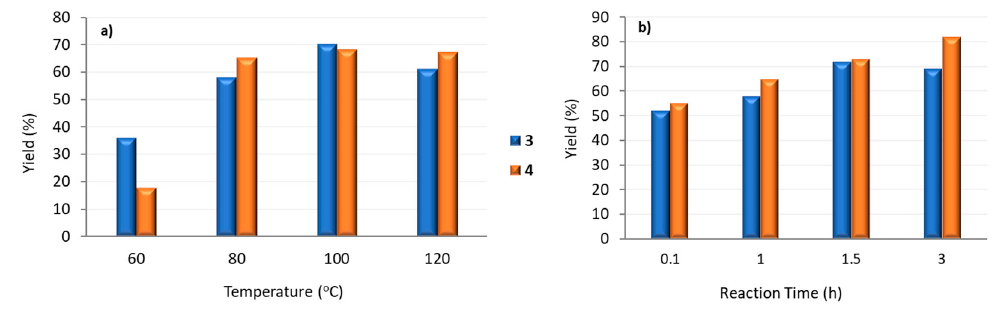
Figure 5. Effect of temperature ( a ) and reaction time ( b ) on acetophenone yield in the MW-assisted peroxidative oxidation of 1-phenylethanol, catalyzed by 3 and 4 . Reaction conditions: 5 mmol substrate, 5 mmol t -BuOOH (aq. 70%), 60–120 °C, 0.1–3 h, MW irradiation (5–10 W).